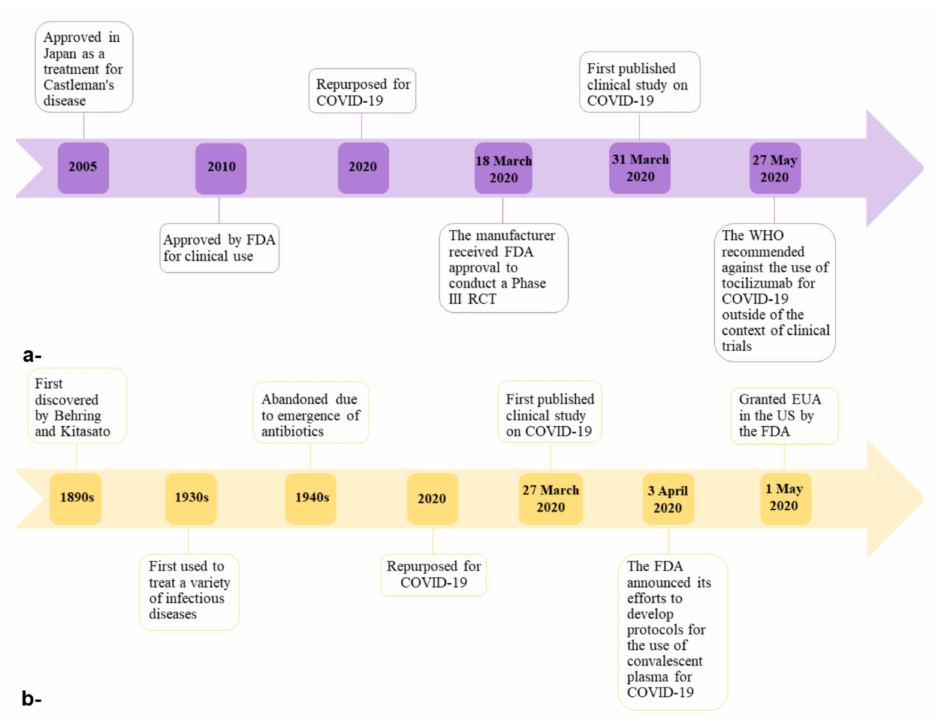
Figure 4. Timelines of tocilizumab ( a ) and convalescent plasma ( b ) from discovery to repurposing for